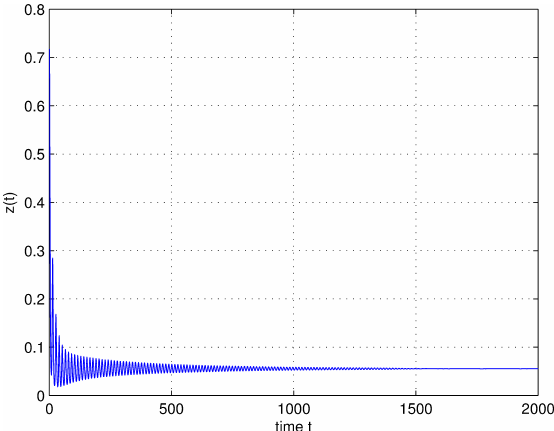
Fig. 3. The trajectory graph of system .26/ in t (cid:0) z plane with (cid:28) 1 D 0:5 , (cid:28) 2 D 0:4 and (cid:28) 3 D 0:3 . The initial value is .x.0/ D 0:8;y.0/ D 0:8;z.0/ D 0:7/ .